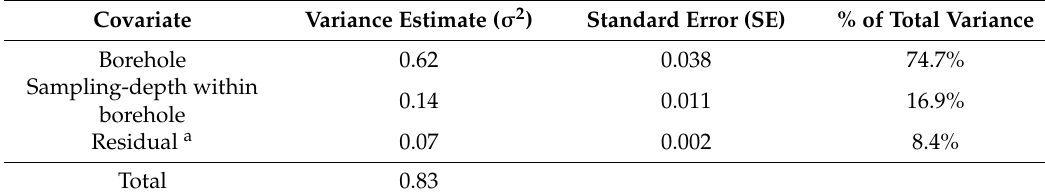
Table 1. Variance estimates of groundwater lithium (Li) levels between borehole, sampling-depth, and date of measurement. Variance estimates were calculated for the log transformation of the groundwater lithium levels ( N = 3682).